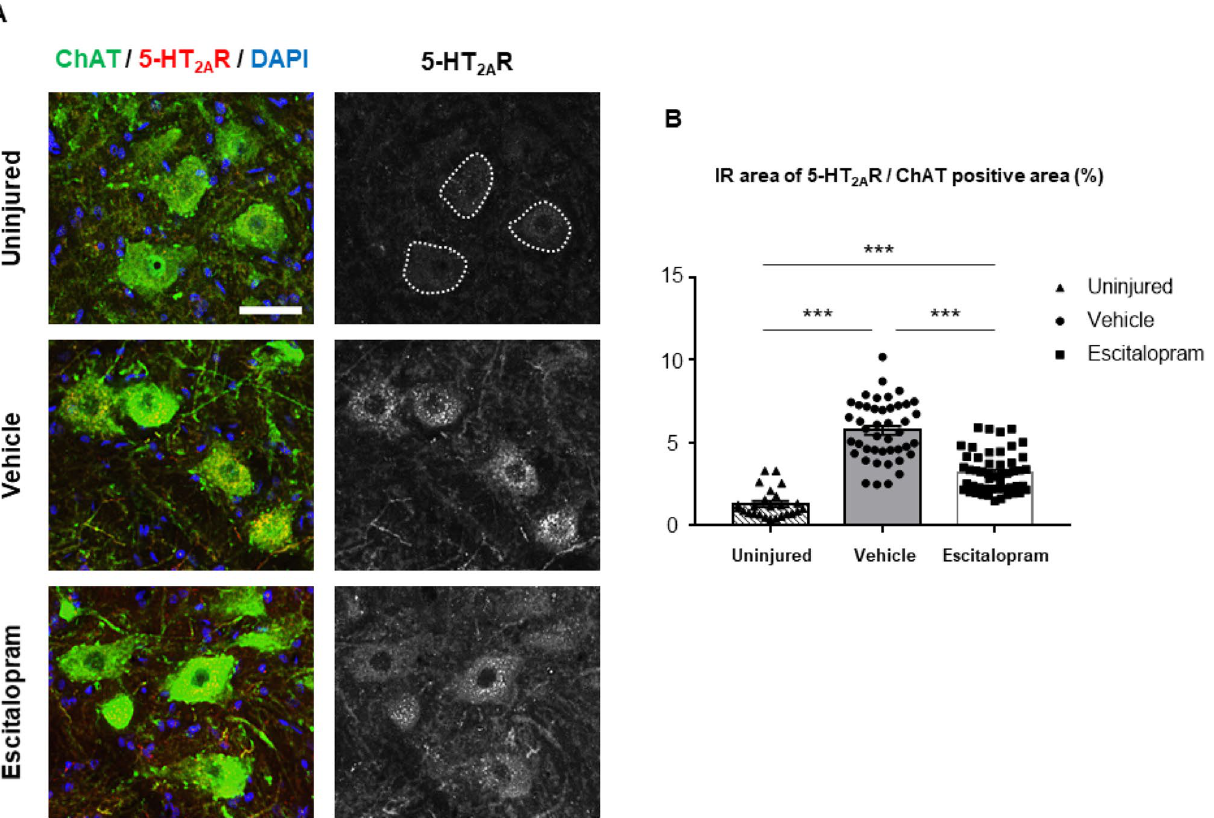
Figure 4. Change of immunoreactivity of the 5-HT 2A receptor in the lumbar spinal cord motor neurons. ( A ) Representative microscopic images of immunoreactivity (IR) of the 5-HT 2A receptor (5-HT 2A R; red) on the lumbar motor neurons of each group are shown. As shown at the top, spinal motor neurons were stained by the anti-ChAT (green) antibody and the IR area of the 5-HT 2A R was confined to the ChAT-stained area (white lines in the binarized image indicate ChAT margins). The nuclei have been stained by 4 ′ ,6-diamidino-2-phenylindole (blue). Scale bar: 50 μm. ( B ) The bar graph with plots presents the quantitative analysis of the IR area of the 5-HT 2A R in the ChAT-positive area of lumbar motor neurons of each group (dashed bar with triangular plots: uninjured group, grey bar with round plots: vehicle-treated group, white bar with rectangular: escitalopram- treated group). *** P <